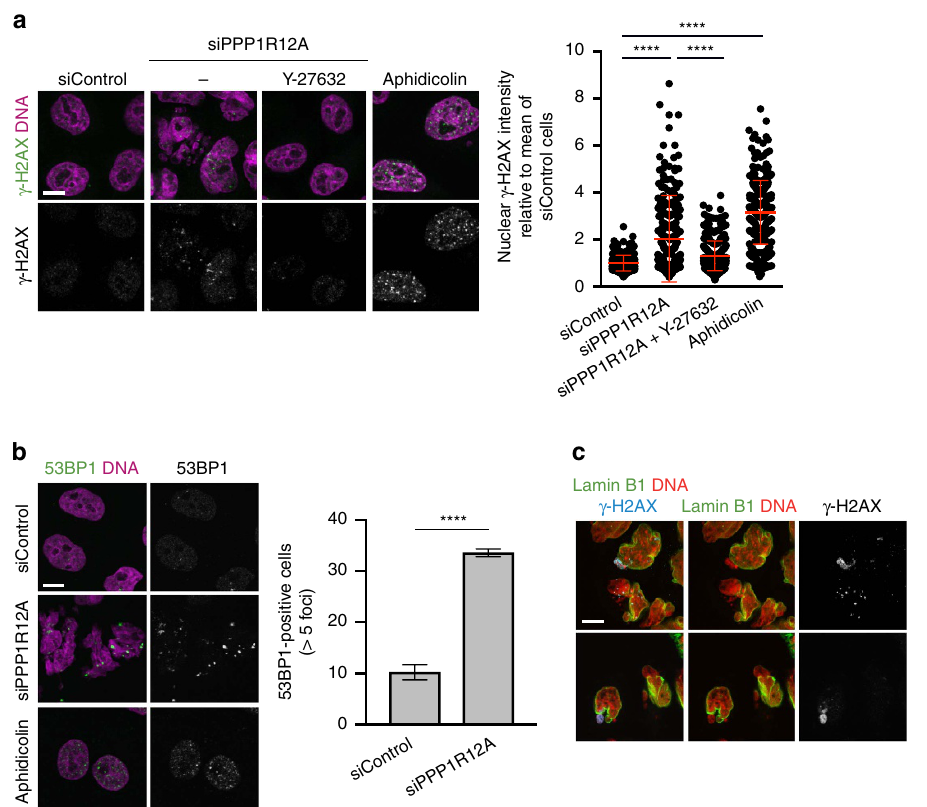
Figure 6 | Induction of DNA damage markers by unrestrained actomyosin activity. ( a , b ) HeLa Kyoto cells transfected with non-targeting control (siControl) or PPP1R12A-siRNA duplexes were processed for immunofluorescence staining 56h after transfection. ( a ) Cells were treated with 5 m M Y-27632 or 400nM aphidicolin for 24h before fixation. Cells were stained with an anti- g -H2AX antibody and DAPI. Representative images (left panel) and the quantification of g -H2AX nuclear signal intensity (right panel) are shown. Mean nuclear intensities of individual cells are plotted. ( b ) Cells were stained with an anti-53BP1 antibody and DAPI. Representative images (left panel) and quantification of 53BP1-positive cells (right panel) are shown. Cells with more than five 53BP1 foci were scored as 53BP1-positive cells. ( c ) HeLa cells transfected with siPPP1R12A were stained with anti-lamin B1, g -H2AX and DAPI. Error bars, s.d. of three independent experiments ( n 4 100 nuclei each) ( a and b ). Graph shows **** P o 0.0001 ( a one-way ANOVATukey’s multiple comparison test; b unpaired t test). Scale bars, 10 m m.